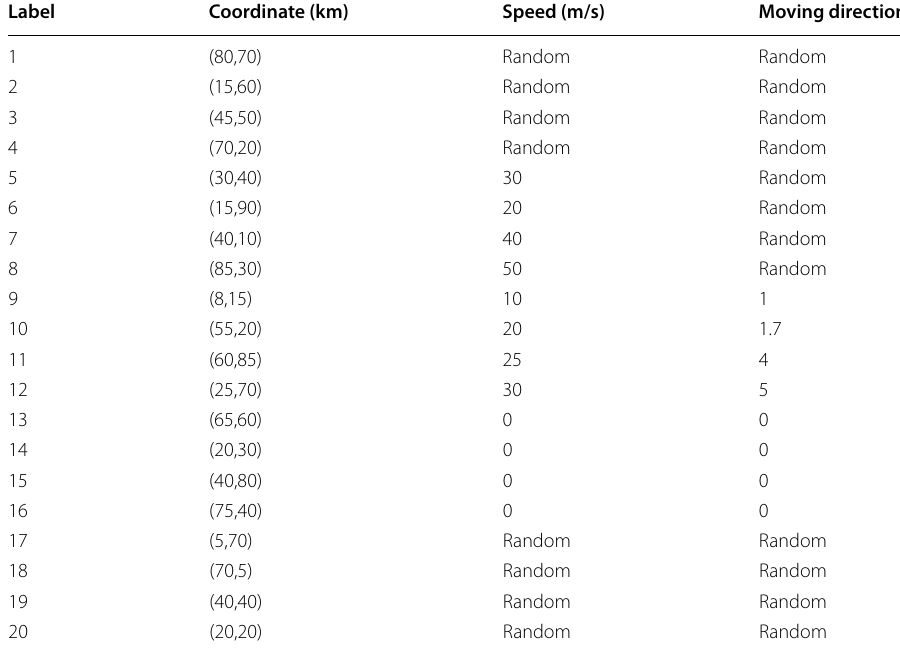
Table 1 Target movement information Label